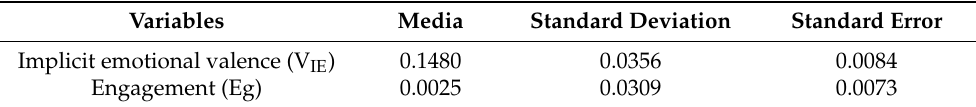
Table 1. Statistic results of the variables in Phase 1.